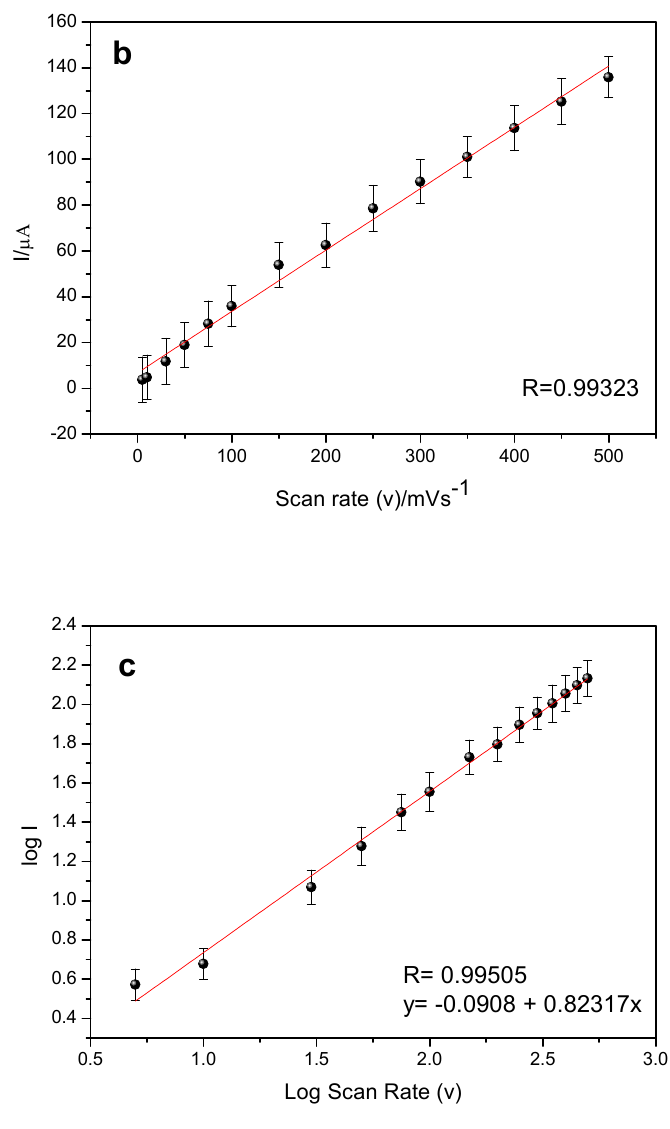
Figure 8. ( a ) Cyclic voltammograms for common sensor varying from 5 to 500 mV s −1 . Concentration of 175 μmol L −1 of ethinyl estradiol. Buffer solution Phosphate 0.10 mol L −1 pH 7.0 ( b ) Ratio of peak current versus scan rate (v) in the range of 5 to 500 mVs −1 , for the same conditions as in Figure 8a and ( c ) Relation between the log of the peak current versus log of the scanning rate, for the same conditions of the Figure 8a.